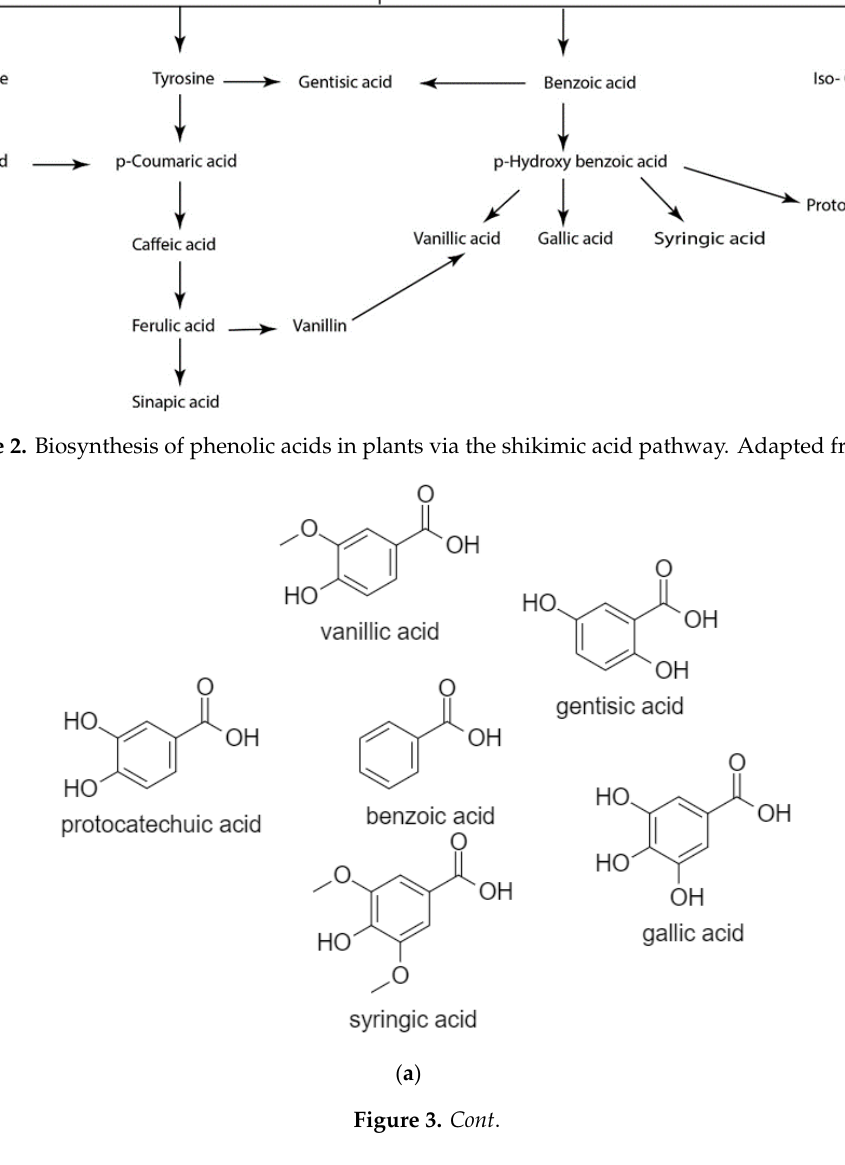
Figure 2. Biosynthesis of phenolic acids in plants via the shikimic acid pathway. Adapted from [3].